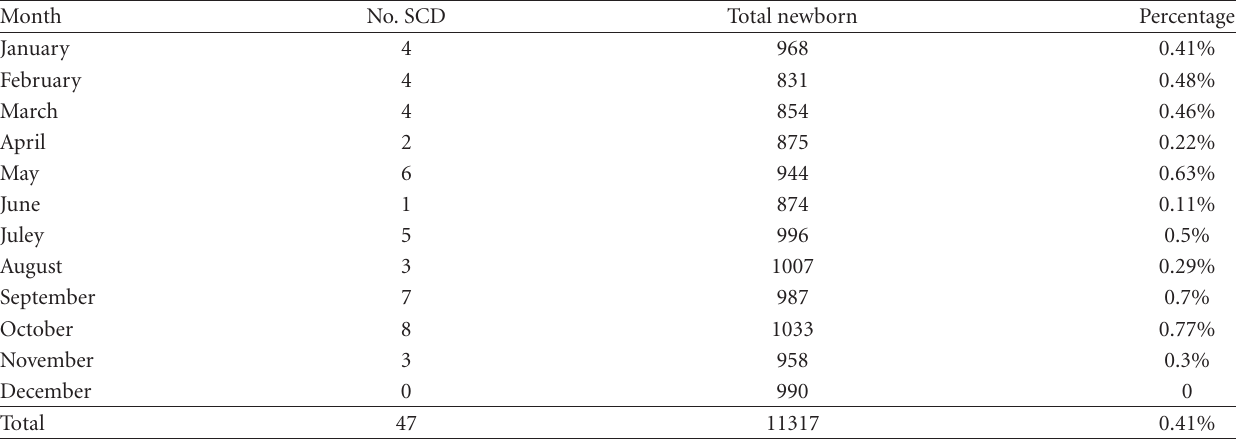
Table 1: A ff ected newborns with sickle cell disease in